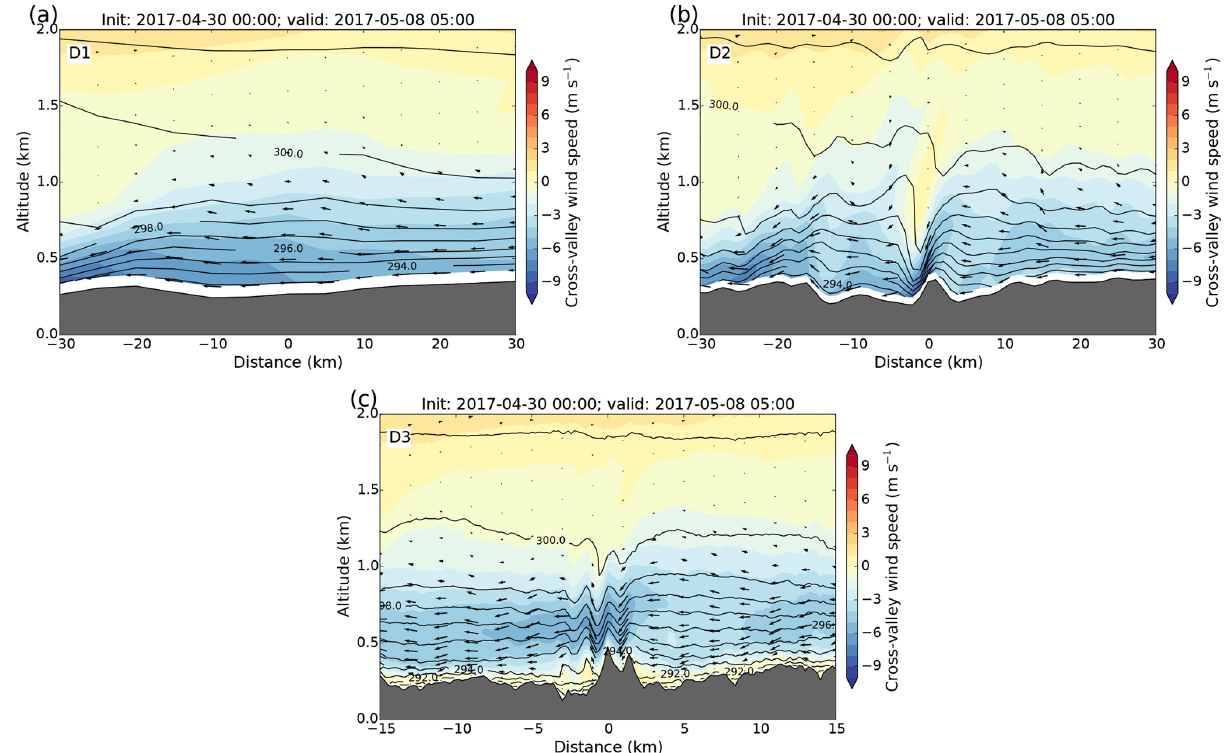
Figure 4. Vertical cross-sections of cross-valley wind speed for WRF domains D1 to D3 valid at 05:00UTC on 8 May 2017. The cross- section is centred at the location of the WT and is oriented in the cross-valley direction (see Fig. 1). In panel (c) , only the half horizontal distance is shown compared to panels (a) and (b)